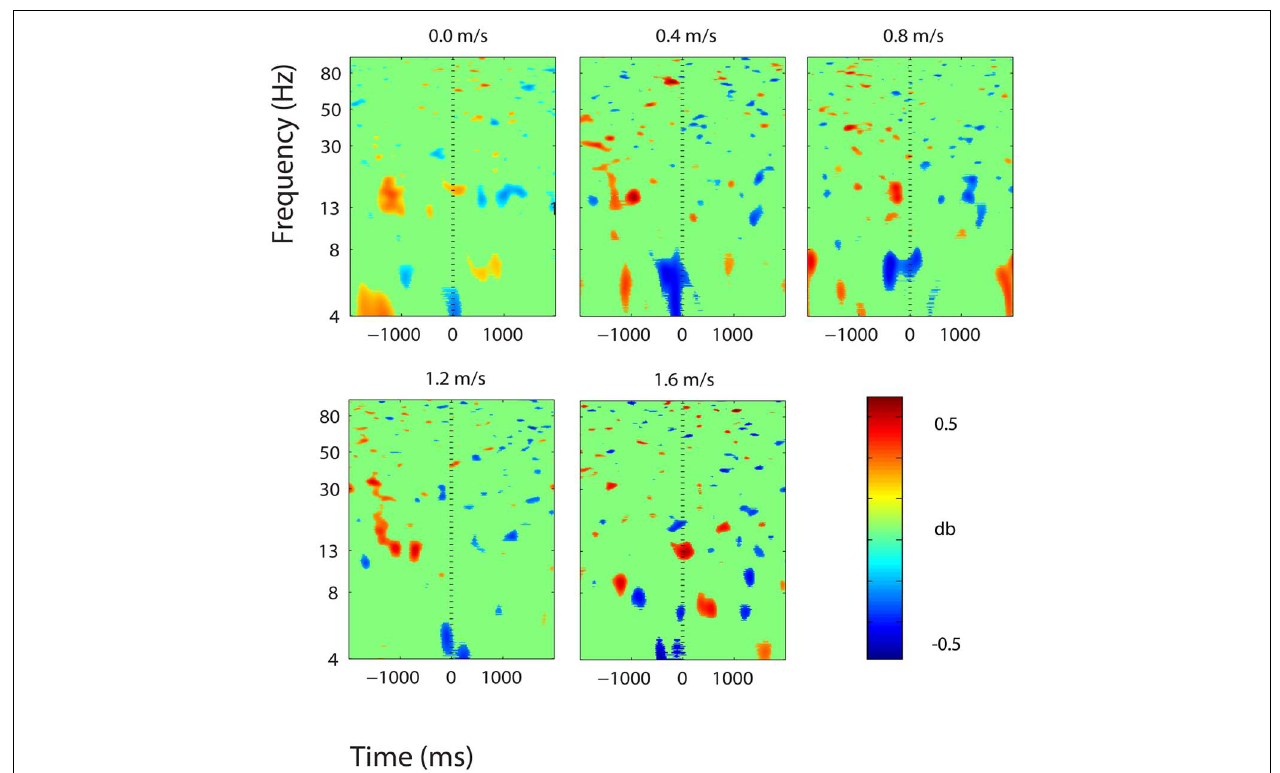
FIGURE 9 | Event-related spectral perturbation plots showing power change around the presentation of a stimulus (a digit and its position in an imagined grid) in the right superior parietal lobule (BA 5). Red represents a power increase from baseline and